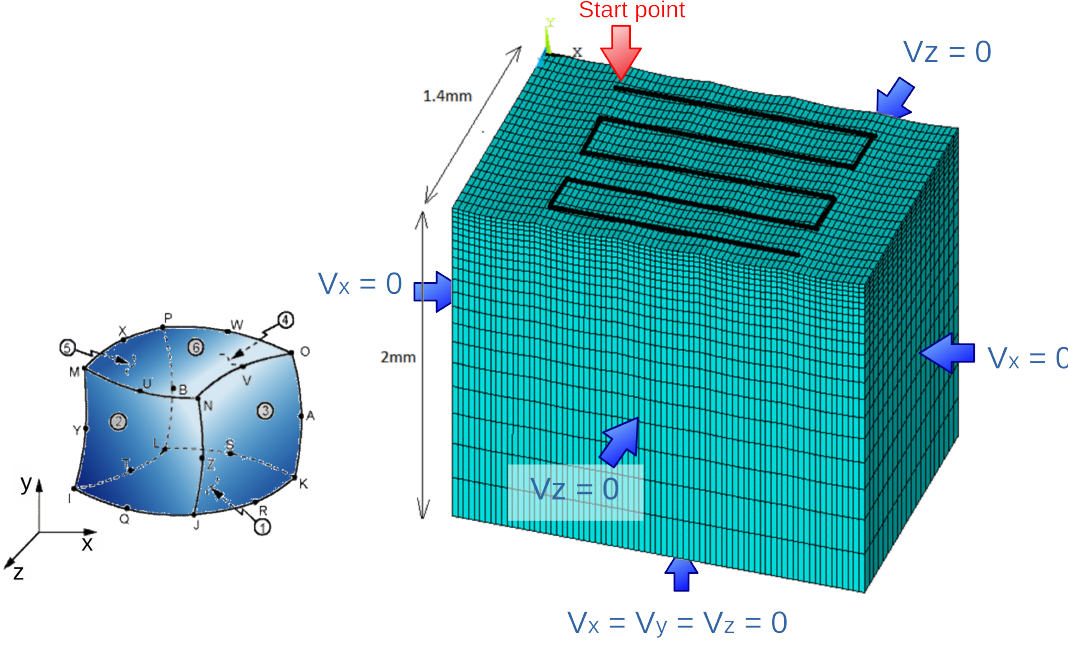
Figure 1. Left . SOLID186 homogeneous structural solid geometry. Right . Overview of modelled surface, boundary conditions and path followed during ball